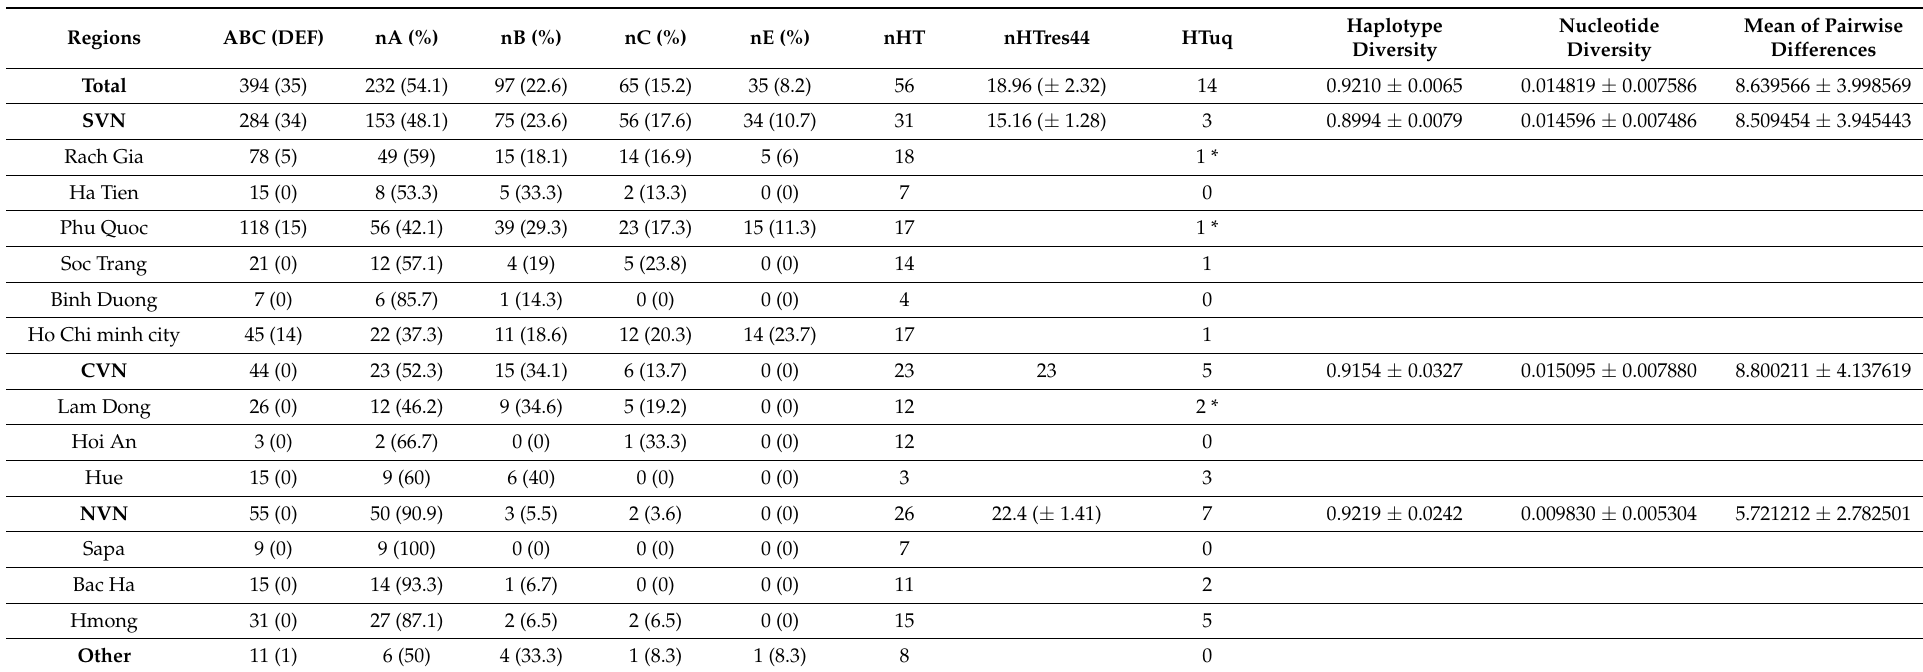
Table 1. Diversity statistics for Vietnamese